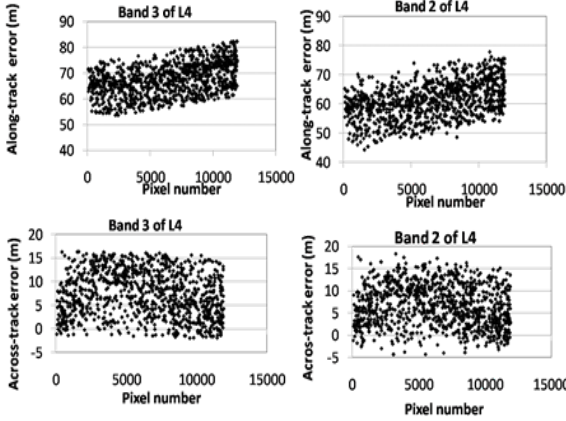
Figure 12 Along-track and across-track errors of band 3 and band2 before correcting the parameters of band 2